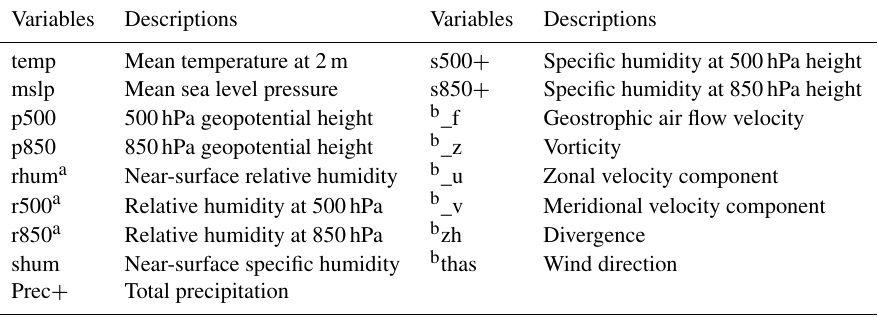
Table 2. Name and description of all NCEP predictors on HadCM3 and canESM2 grid. Variables